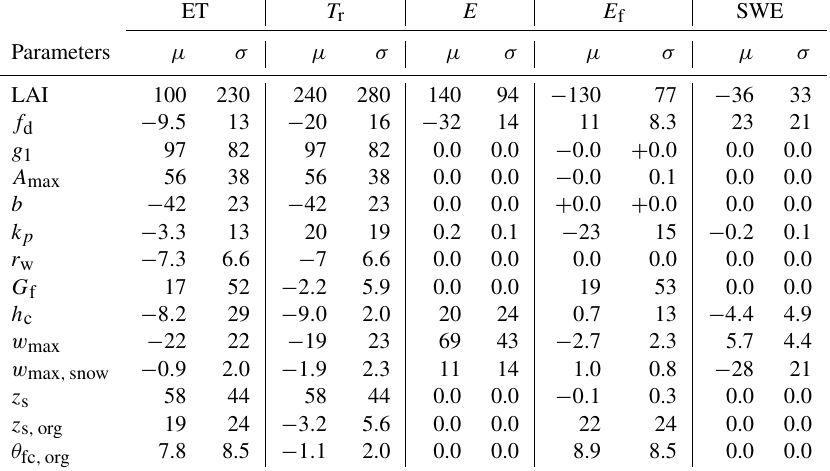
Table 4. Sensitivity of Canopy submodel predictions to parameter variability. Mean ( µ ) and standard deviation ( σ ) of the distribution of elementary effects for evapotranspiration (ET), transpiration ( T r ), evaporation from canopy interception ( E ), ground evaporation ( E f ), and annual maximum snow water equivalent (SWE). A negative sign of µ indicate output variable decreases when parameter value increases. Units are in millimeters per year (mm a − 1 ) except for SWE